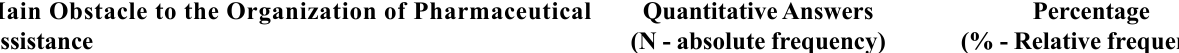
TABLE IV - Main obstacle to the organization of pharmaceutical assistance, according to pharmacists of Maranhão State (n = 78) Main Obstacle to the Organization of Pharmaceutical